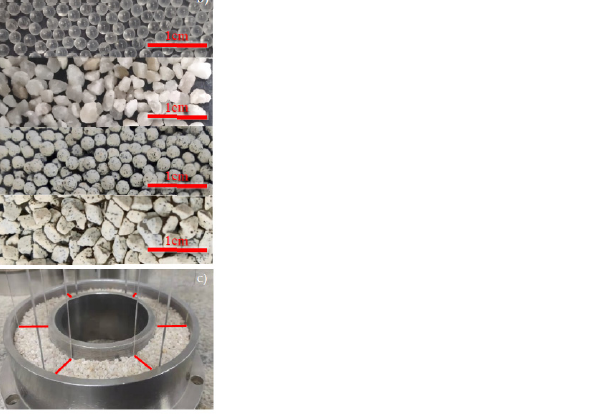
Figure 1. The basic condition of the ring-shear test. ( a ) Structure of GCTS ring-shear apparatus; ( b ) Initial photos of experimental materials; ( c ) Partition filling method. This figure was modified from Huang et al. [24].